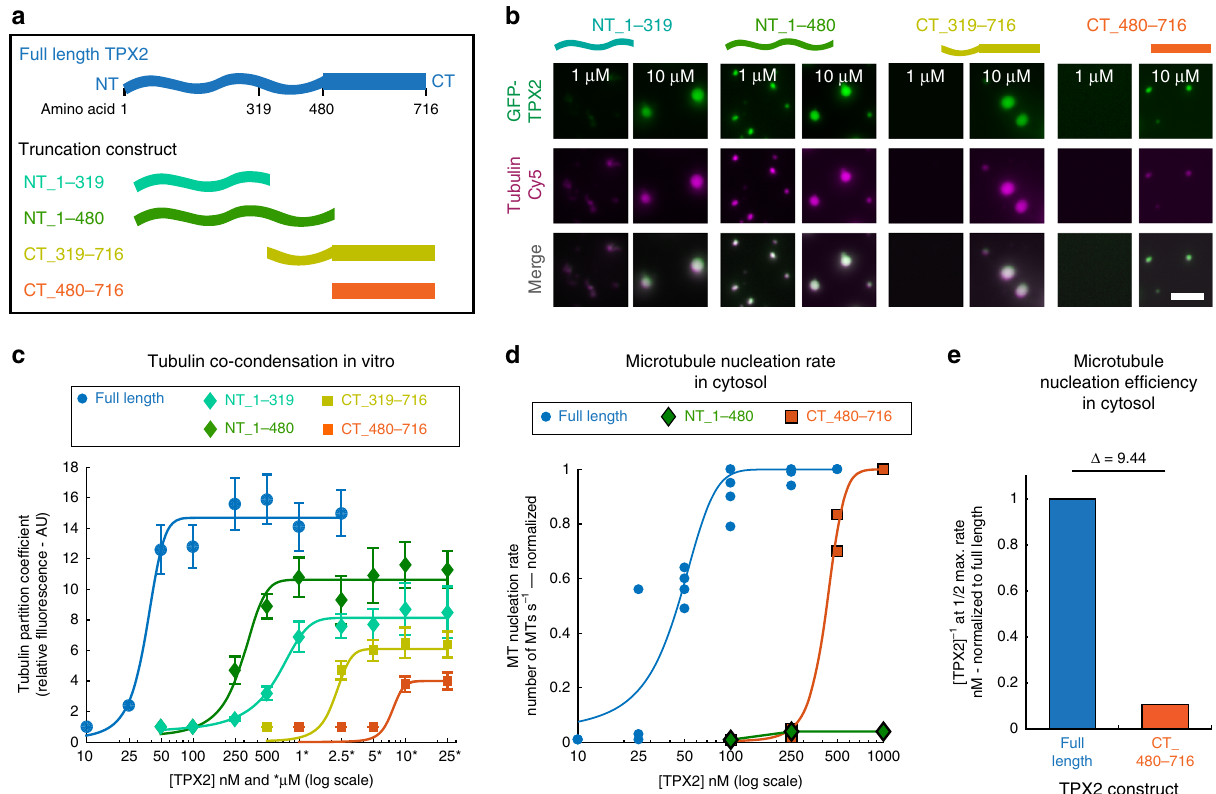
Fig. 4 TPX2 N-terminus enhances condensation and MT nucleation ef fi ciency. a Schematic of full-length TPX2 and various N-terminal and C-terminal truncation constructs used. b Epi fl uorescent images of GFP-TPX2 (green) and Cy5-labeled tubulin (magenta) co-condensates at 1 µ M and 10 µ M (equimolar concentration) for indicated TPX2 truncation construct. Representative of three experimental replicates. c Quanti fi cation of relative tubulin